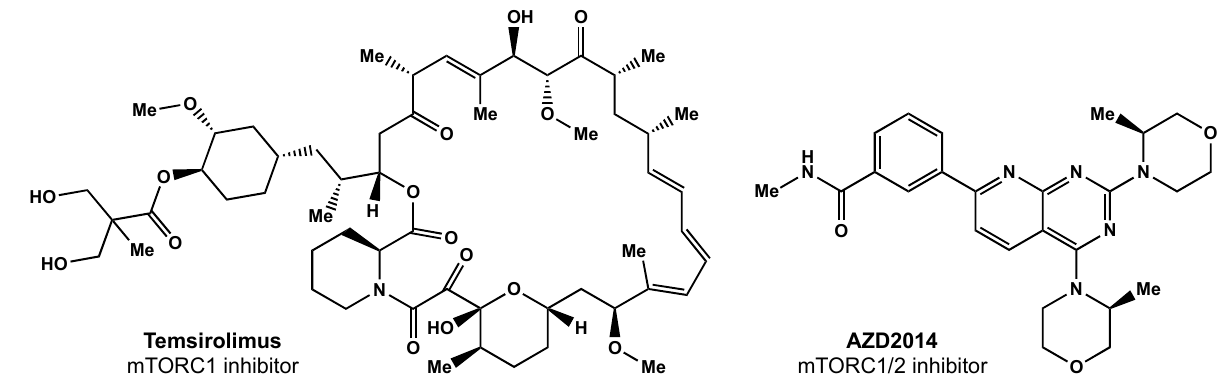
Figure 4. Small molecule inhibitors of mTOR.